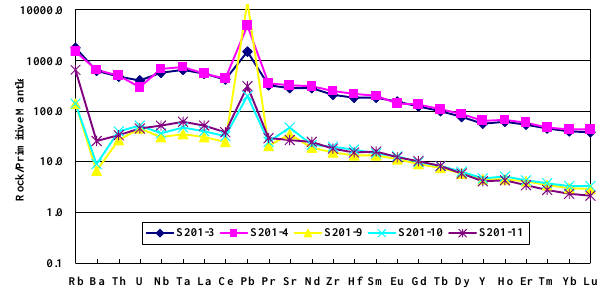
Fig. 6. Spider diagrams of Primitive mantle-normalized trace el- Fig. 6 . Spider diagrams of Primitive mantle-normalized trace element concentrations ement concentrations. (Normalizing values from Sun and Mc Donough, 1989.) Fig. 6 is the spider ent concentrations. In Fig.6,